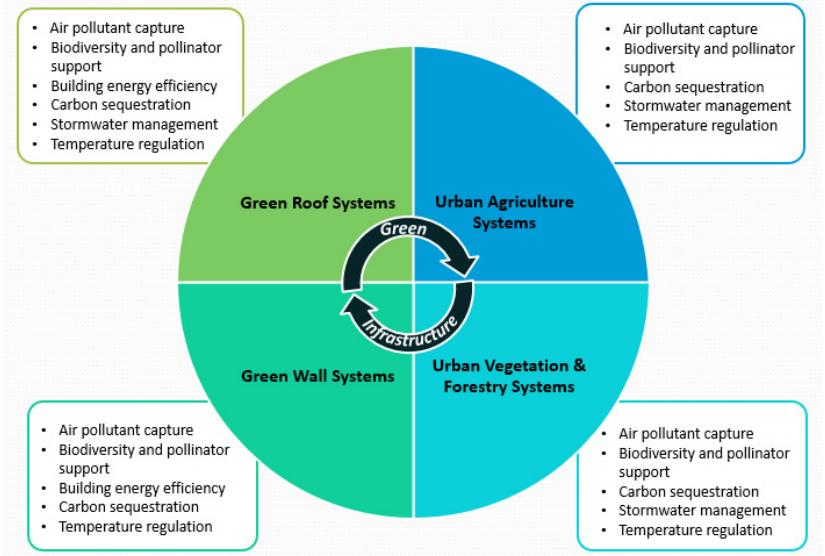
Figure 1. Green infrastructure form and function (Source: [5,6,29–31,36,37]). Green infrastructure has been shown to have a positive effect on near-surface air temperatures and LST, as a result of shading and evapotranspiration [38,39]. The temperature factors including irrigation, local climate, physical dimension, seasonality, and